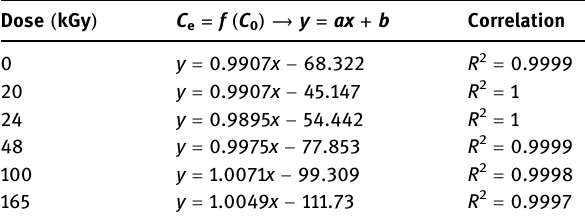
Table 2: Characterization of adsorption curve shifts compared with the curves in Figure 1 using plot of C e = f ( C 0 ) Dose ( kGy ) C e = f ( C 0 ) → y = ax + b